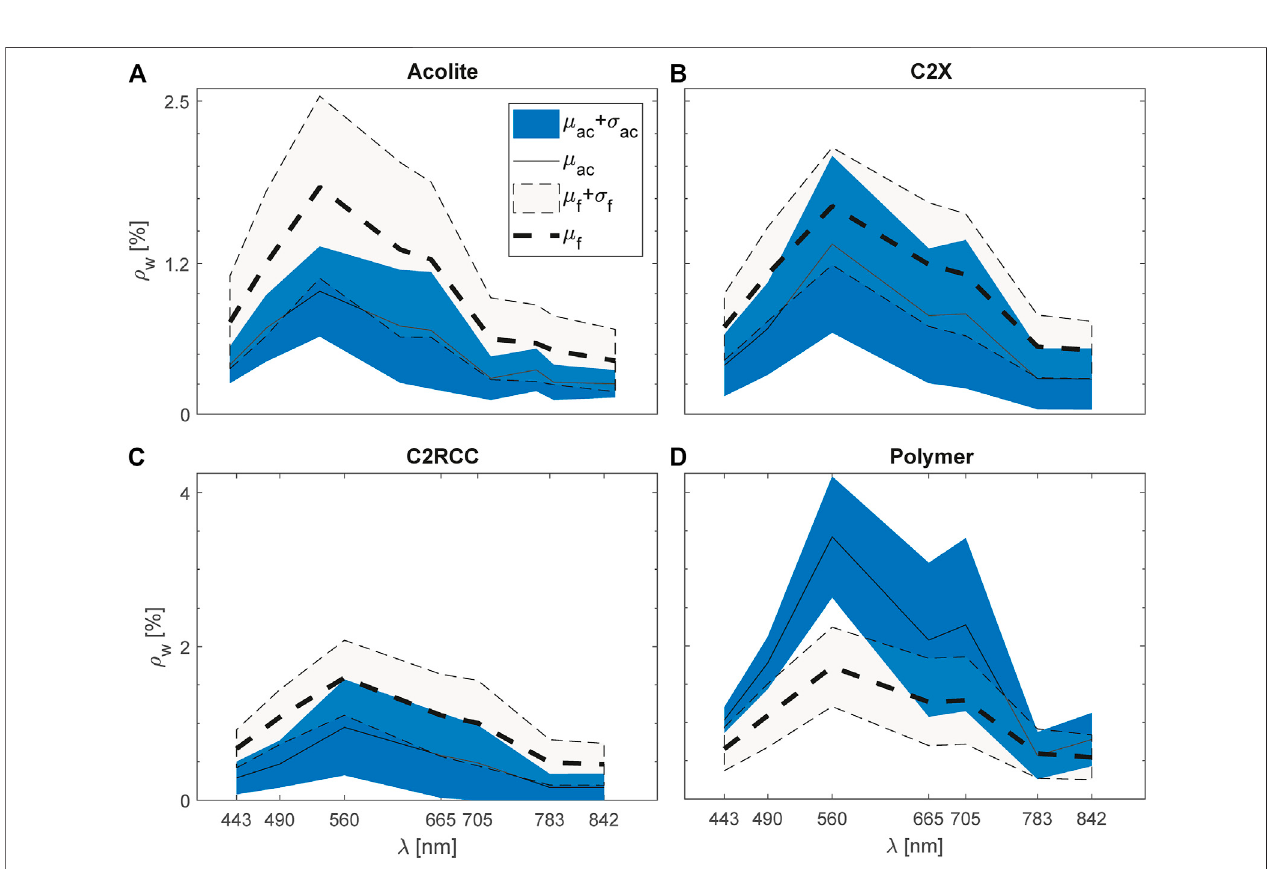
FIGURE 2 | Summary of the results from applying atmospheric correction to S2-MSI using (A) Acolite, (B) C2X, (C) C2RCC and (D) Polymer. Solid lines depict averagevalues,whereasshaded areas represent thevariabilityasstandarddeviation. Thesubscripts, ac , f refertoatmospherecorrectionand fi eldspectra, respectively.